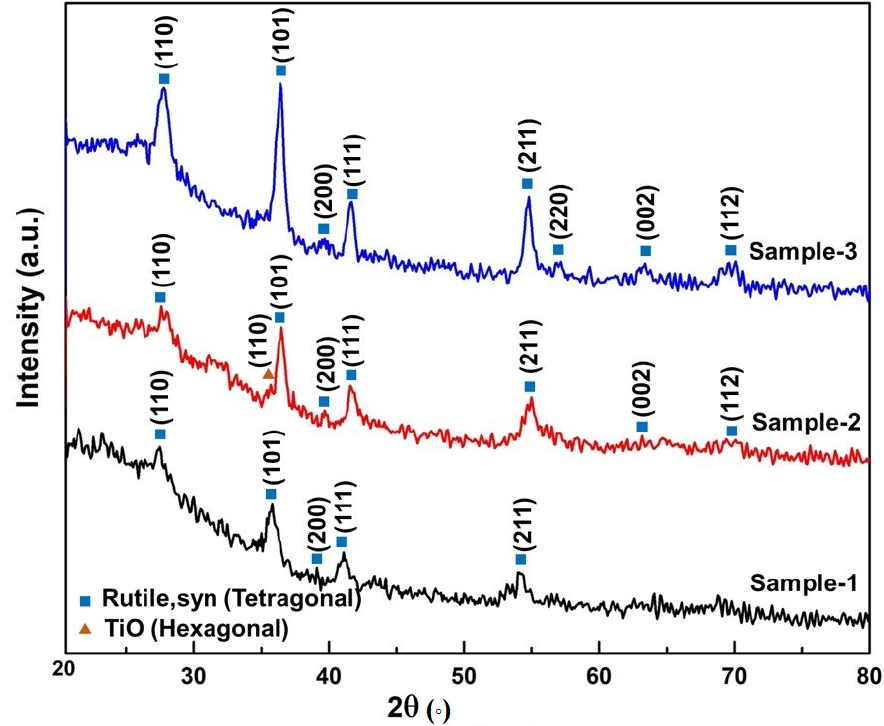
Figure 3. Thin-film X-ray diffraction patterns with different sputtering process parameters thermally oxidized at 550°C. Table 1. Optimized lattice parameters of the rutile phase in Ti-TiO 2 bilayer thin-film samples as a function of oxidation